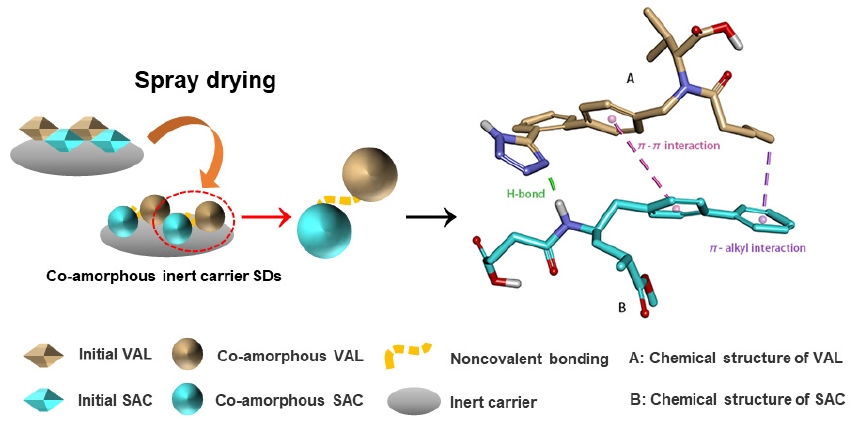
Figure 1. Schematic illustration of the sacubitril-valsartan (SAC-VAL) co-amorphous formulations.